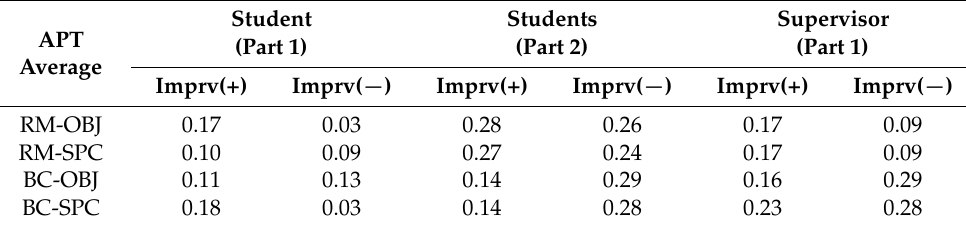
Table 8. Improvement Index for APT Project (Part 1 and Part